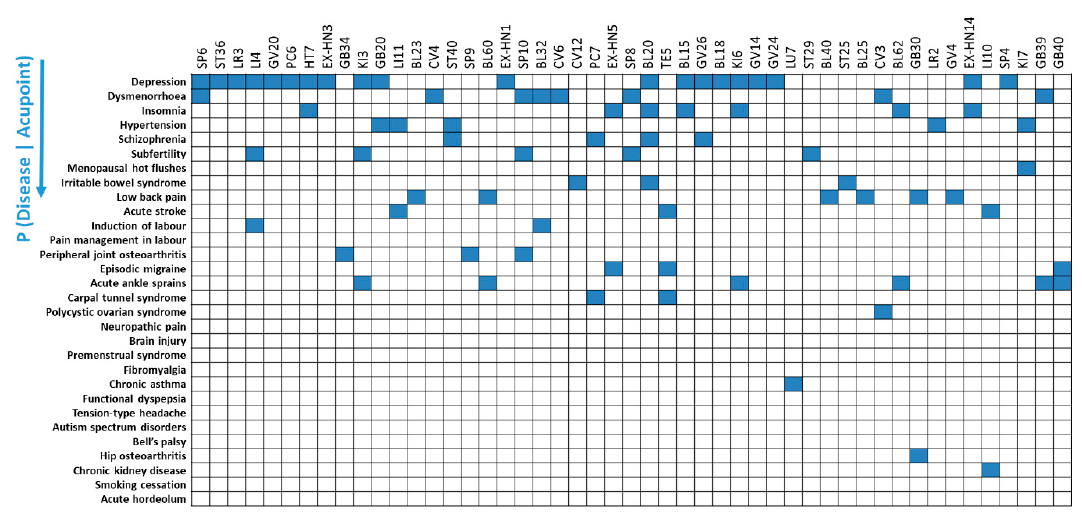
Figure 3. Patterns of acupoint indications for 49 acupoints using reverse inference. Depression was the most prominent indication across the 49 acupoints, while different acupoint indications were also found for each acupoint. Z-scores indicate the frequency at which each disease was treated by each acupoint compared to the indications for that acupoint.